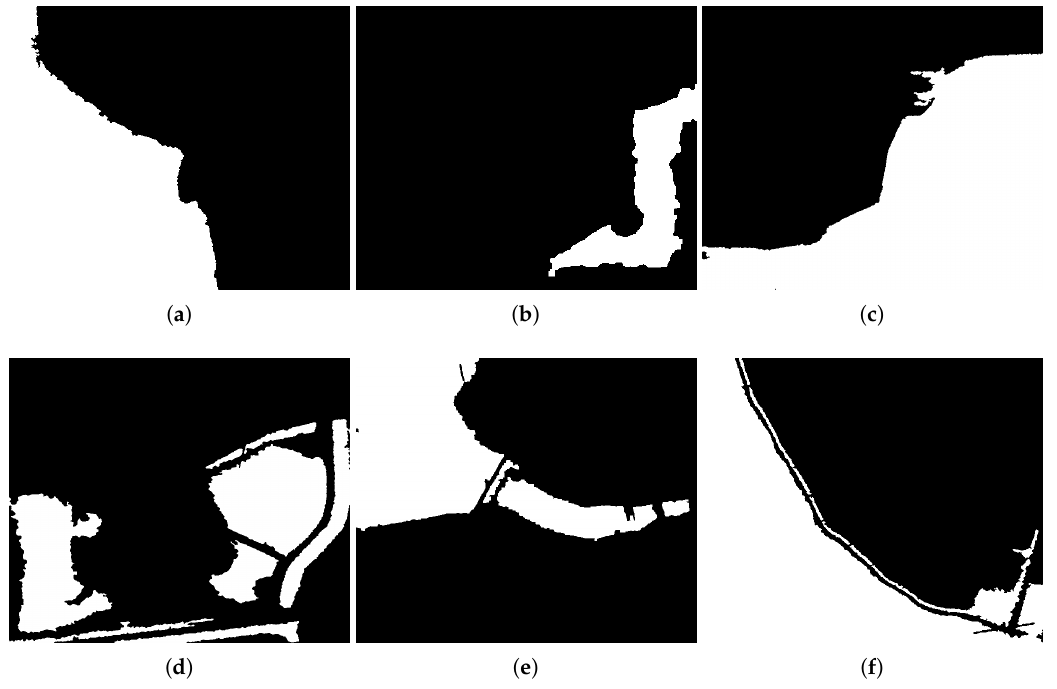
Figure 6. Water detection results of the Tracing Direction Searching (TDS)